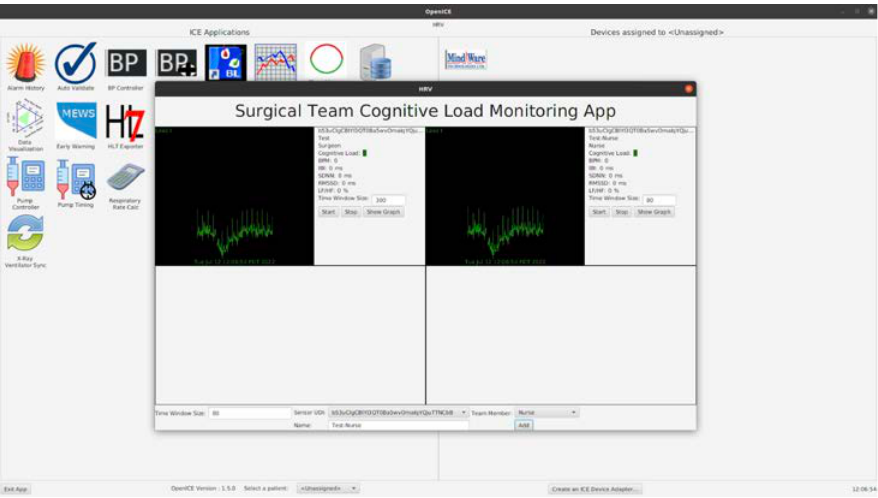
Figure 4. COR - ICE HRV Analysis App UI .